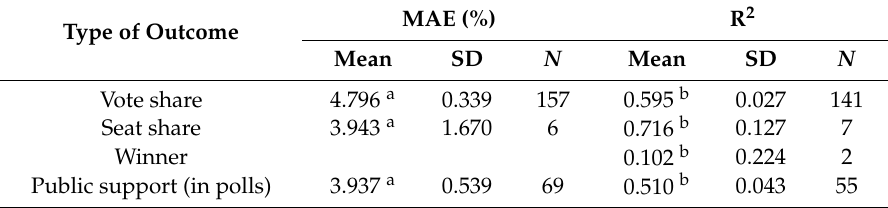
Table 3. Covariate-adjusted means for di ff erent types of election and poll-based predictions. Type of